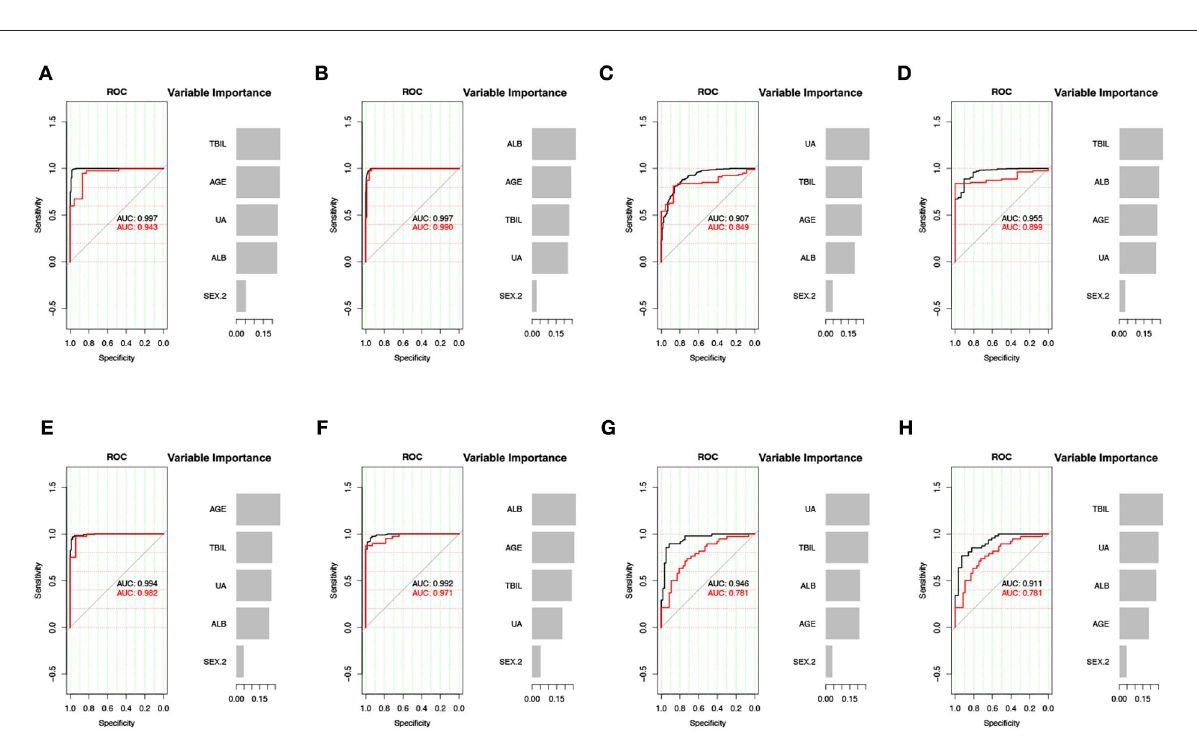
among 3 groups were significant; the UA and TBIL levels of the BD and MDD groups were higher than those of the HC group, while their ALB levels were lower than